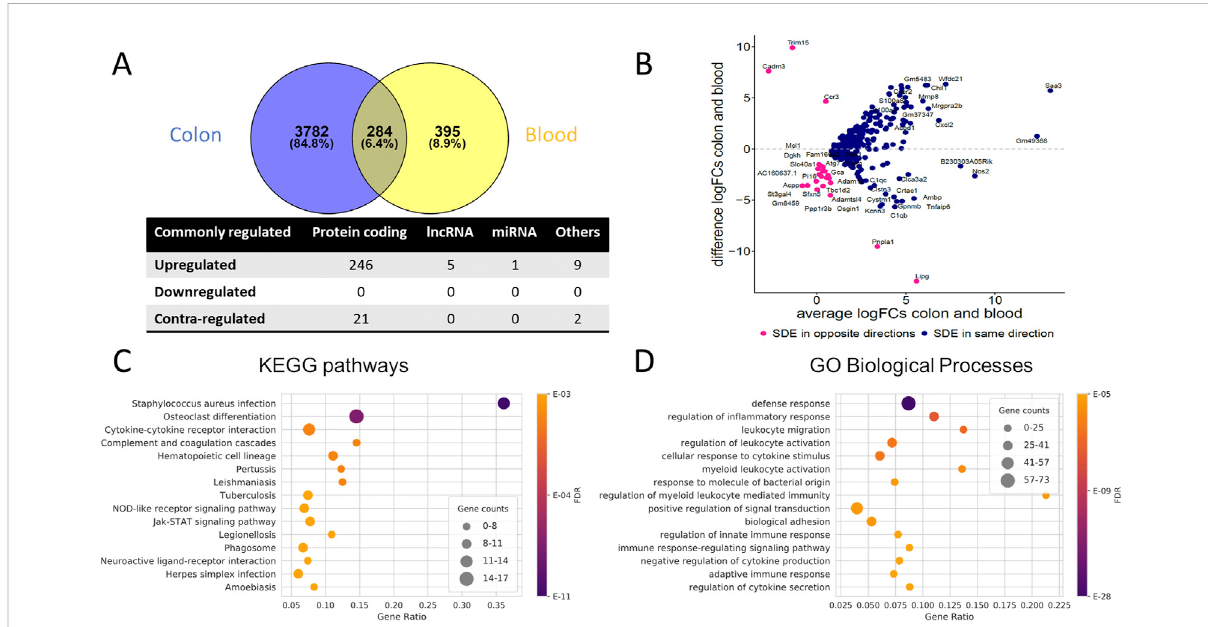
FIGURE 2 CommonlydysregulatedSDEgenesinUCmousecolonandblood. (A) VenndiagramoftheSDEgenesoverlapbetweencolonandblood;Other RNAs include pseudogenes, TEC, snoRNA, miscRNA, etc. Contra-regulated genes are commonly SDE genes in both tissues, which are regulated in opposite directions (B) MA Plot showing the relationships between log 2 FC in colon and blood for each of the common SDE genes; y-axis indicates whether the gene has a higher FC in colon or blood, x-axis re fl ects the cumulative FCs magnitude in colon and blood. Genes labeled as an outlier in each tissue were removed from the plot. (C) Top 15 enriched KEGG pathways and (D) Top 15 enriched GO biological processes for the common SDE genes between mouse blood and colon. Gene ratio corresponds to the ratio between the number of common SDE and all expressed genesinthepathway.ThedotsizeindicatesthenumberofSDEgenes(genecounts),whilethecolorrepresentstheenrichmentsigni fi canceasgiven by the FDR adjusted p